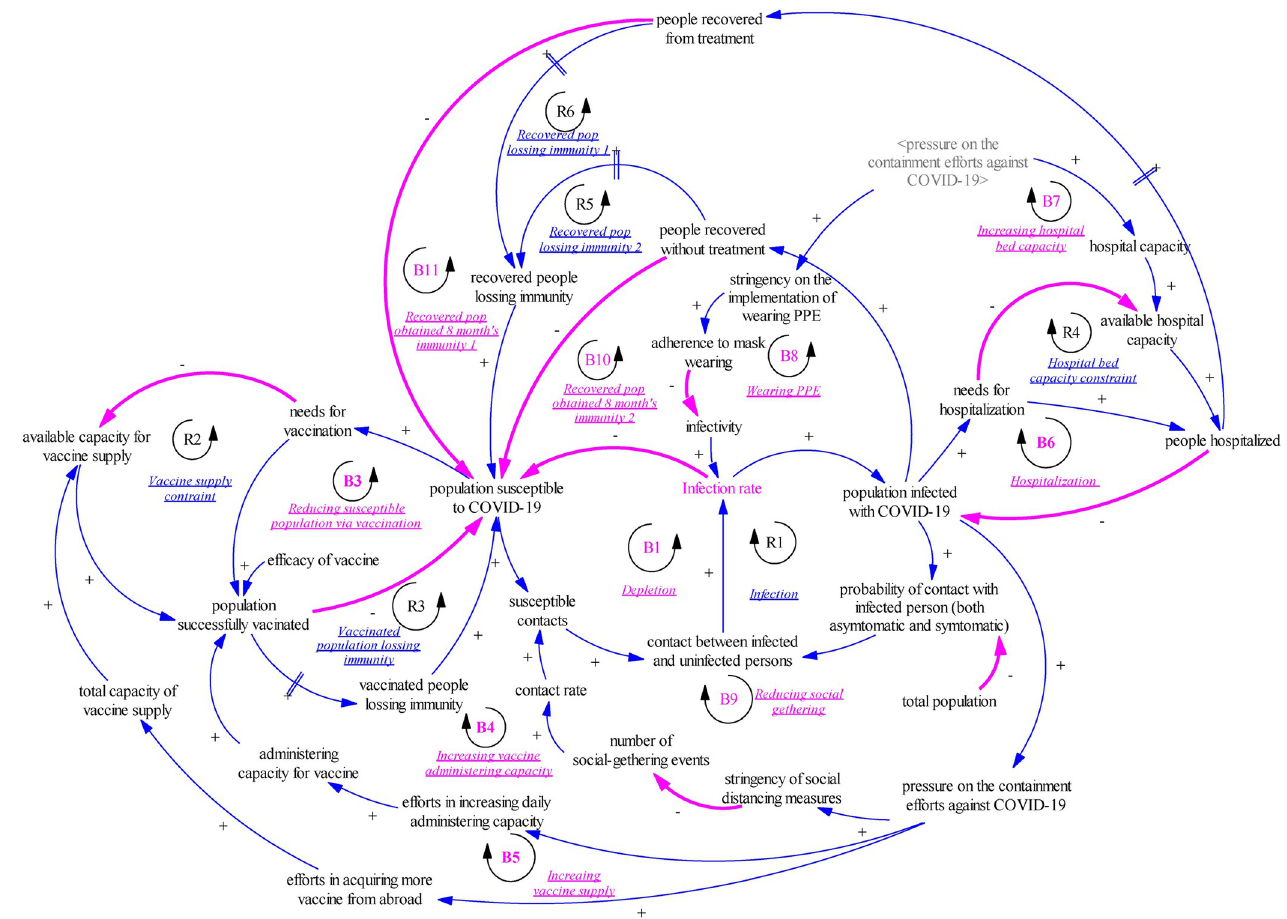
Fig 1. Causal loop diagram for the system dynamics